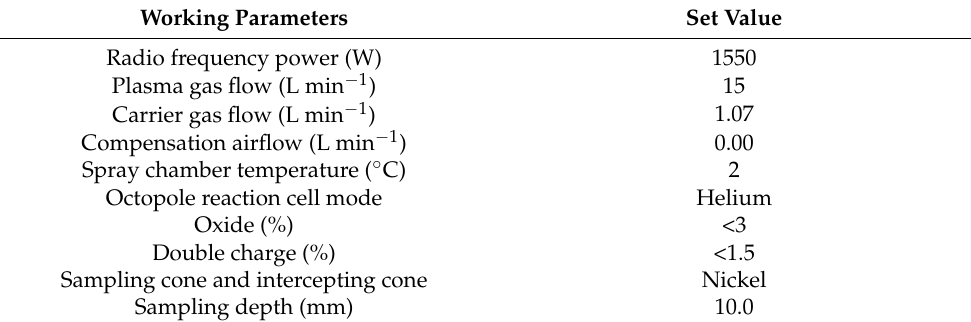
Table 2. The main working parameters of ICP-MS.